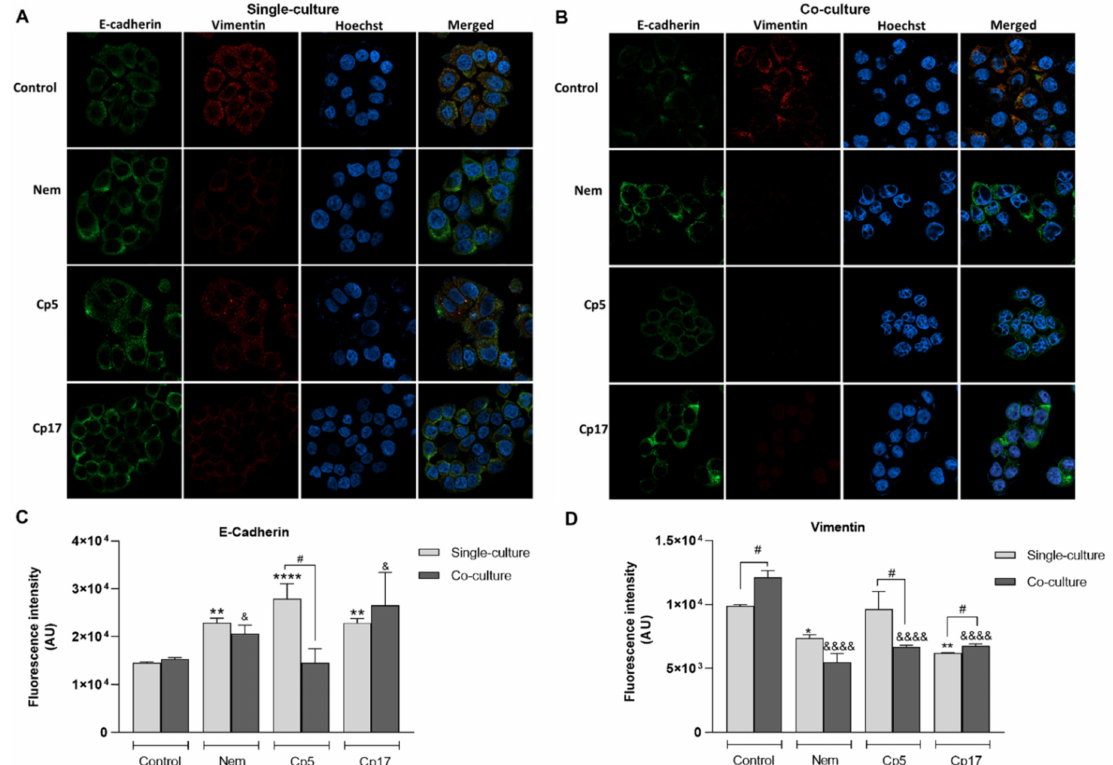
Figure 7. E ff ect of Nem, Cp5 or Cp17 (concentrations used, 12 µ M, 25 µ g / mL, 13 µ g / mL, respectively) (half IC 50 / 24 h, Table 3) on the expression of EMT-related markers E-cadherin and vimentin in HT-29 cells. ( A ) Single culture; ( B ) co-culture with M2-like macrophages. Images magnification: 40 × , E-cadherin is stained in green and vimentin in red. ( C – D ) Nuclei are stained blue with Hoechst. Data reported as the mean ± SD of three independent experiments. * p < 0.05, ** p < 0.01, **** p < 0.0001 vs. control (single culture). & p < 0.05, &&&& p < 0.0001 vs. control (co-culture), # p < 0.05 di ff erence between single and